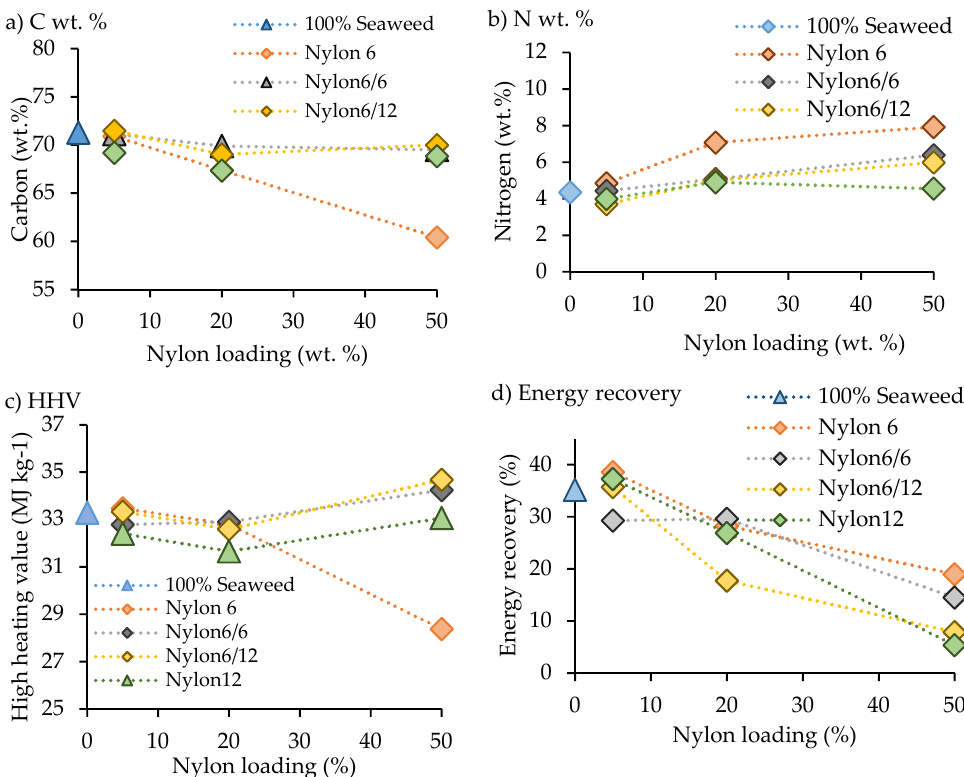
Figure 5. Biocrude compositions produced from the coliquefaction of macroalgae biomass with nylon 6, nylon 6/6, nylon 6/12 and nylon 12; ( a ) is carbon wt.%, ( b ) nitrogen wt.%, ( c ) high heating value (HHV) of the biocrudes, ( d ) energy recovery (%) .